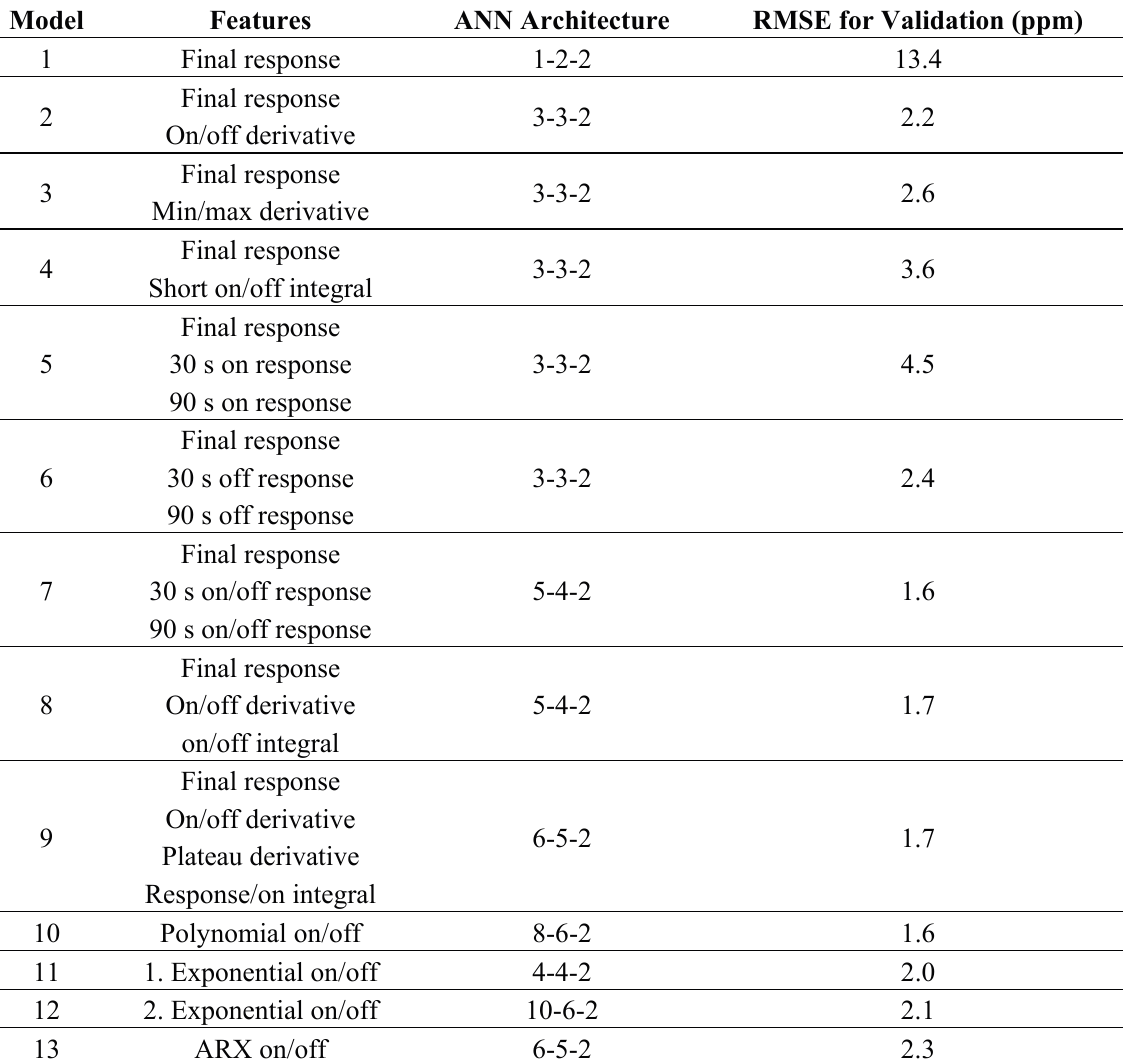
Table 7. Results of neural network estimation from different features in